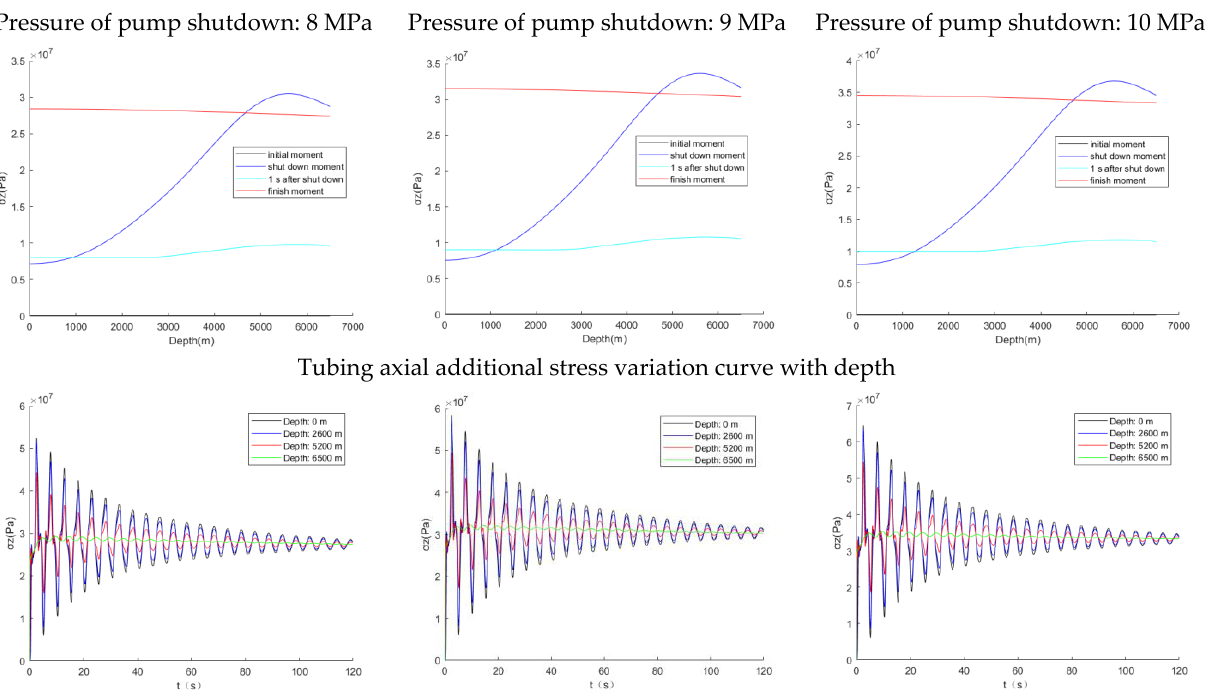
Figure 9. Variation curve of tubing vibration speed under different initial shutdown pressure.